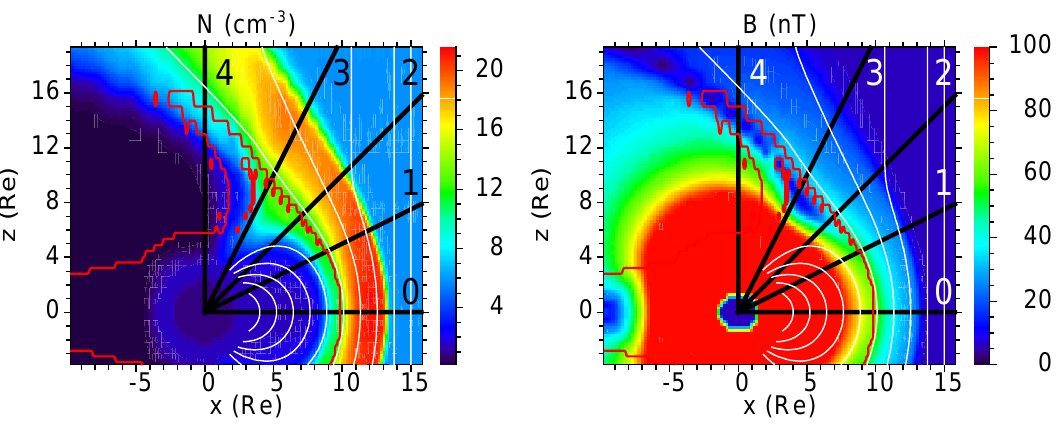
Fig. 3. The plasma density and the magnetic field magnitude in the y =0 plane. Magnetic field lines are shown as white smooth curves. The other formats of the figure are the same as those in Fig. 2. The plasma and field values along the radial lines are shown in Fig. 5. has shown very little difference. Because of the